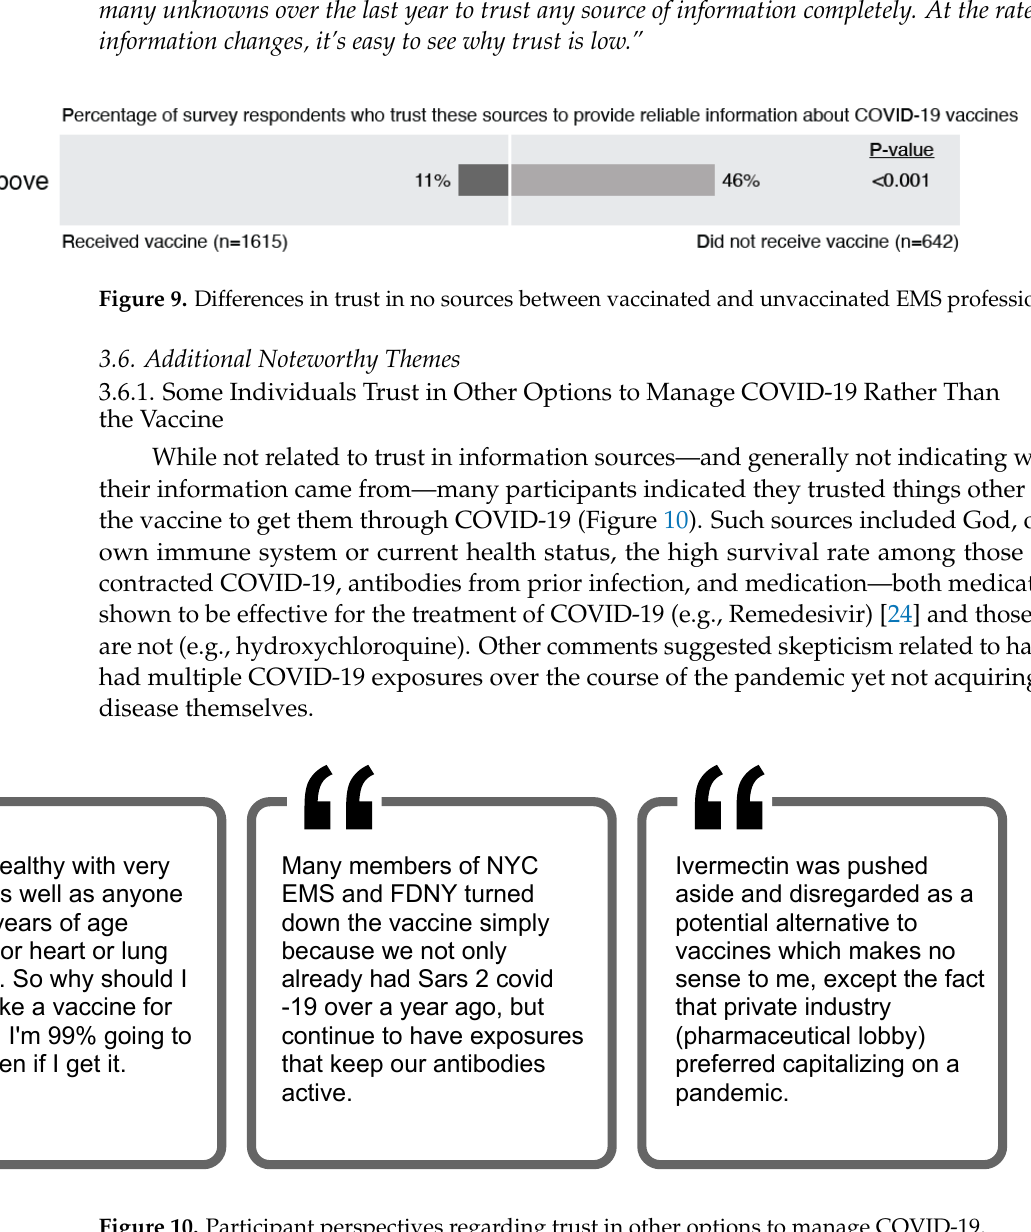
Figure 10. Participant perspectives regarding trust in other options to manage COVID-19.